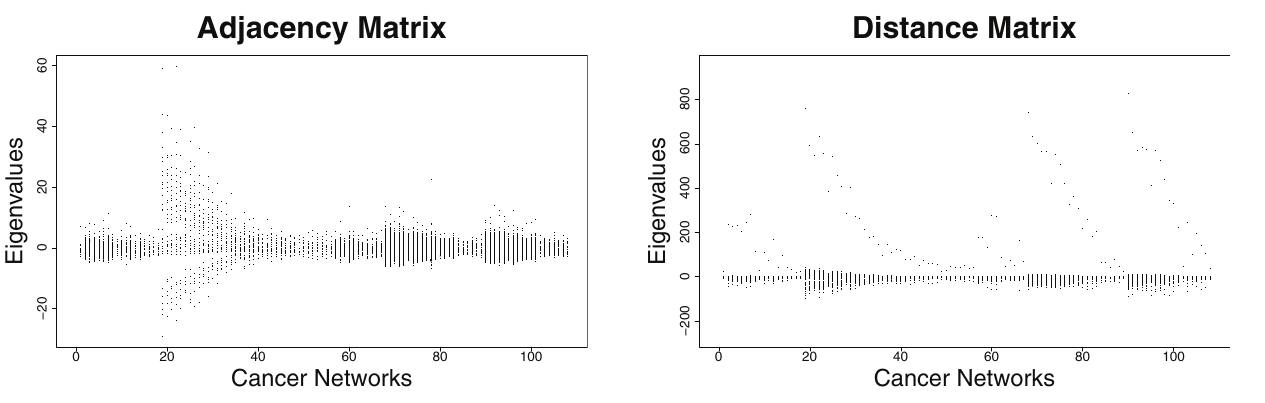
Figure 2. Distributions of the Eigenvalues of the adjacency matrix for the cancer networks.